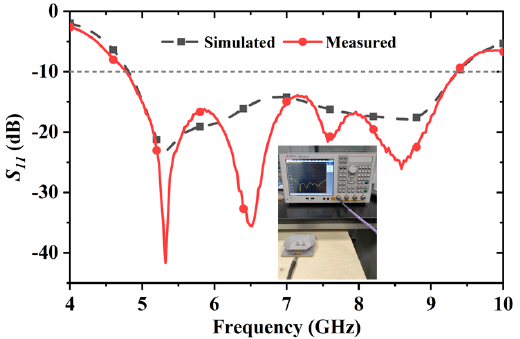
Figure 15. Simulated and measured return loss of the proposed antenna.